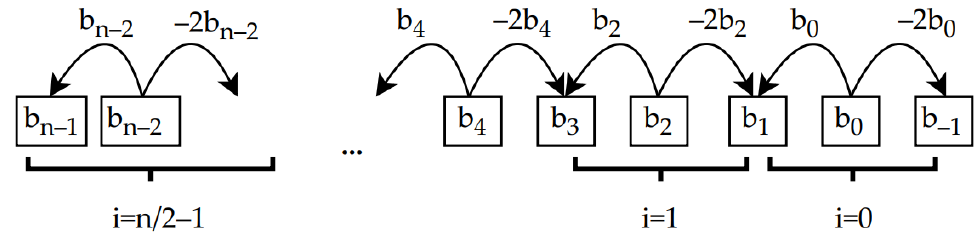
Figure 1. Decomposition of even bits into their neighbors when calculating partial products.